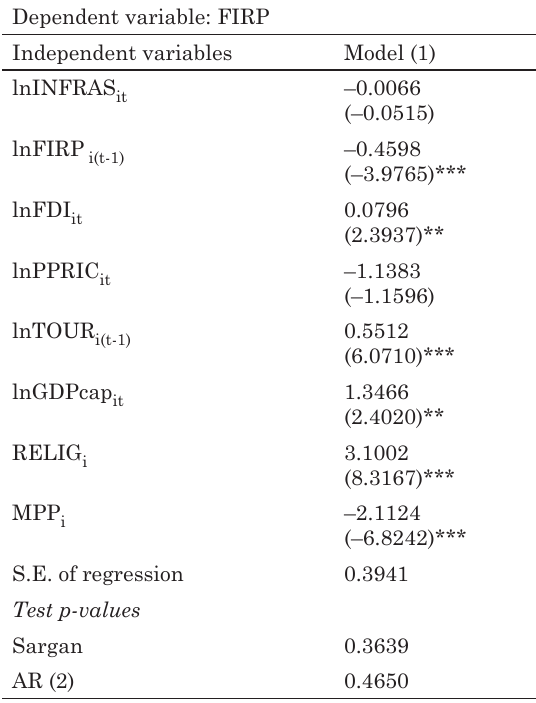
Table 4. GMM system regression